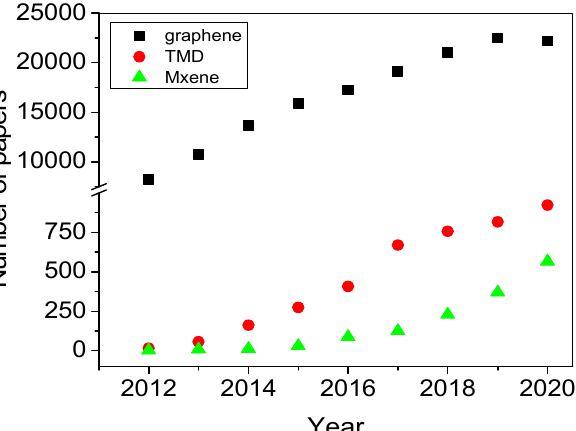
Figure 1. Number of published scientific articles per year since 2012 referring to graphene (black squares), TMDs (red circles) or MXenes (green triangles) in their abstract (source: Scopus, Febru- ary 2021).